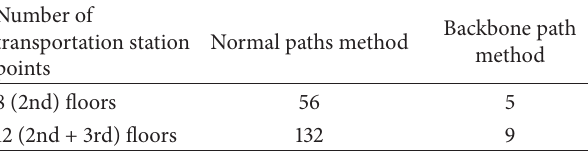
Table 1: Static method and backbone